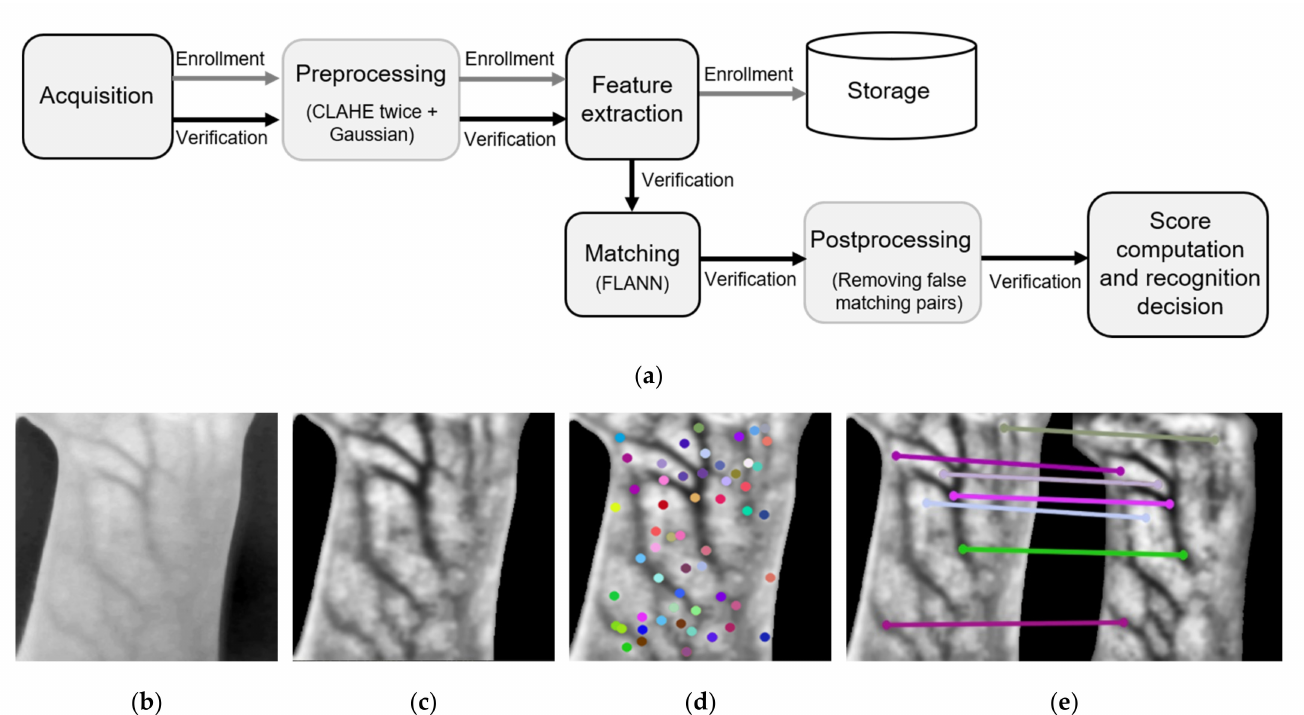
Figure 5. ( a ) Biometric recognition process implemented in this work. Wrist result examples of ( b ) acquisition, ( c ) preprocessing, ( d ) SIFT feature extraction, and ( e )